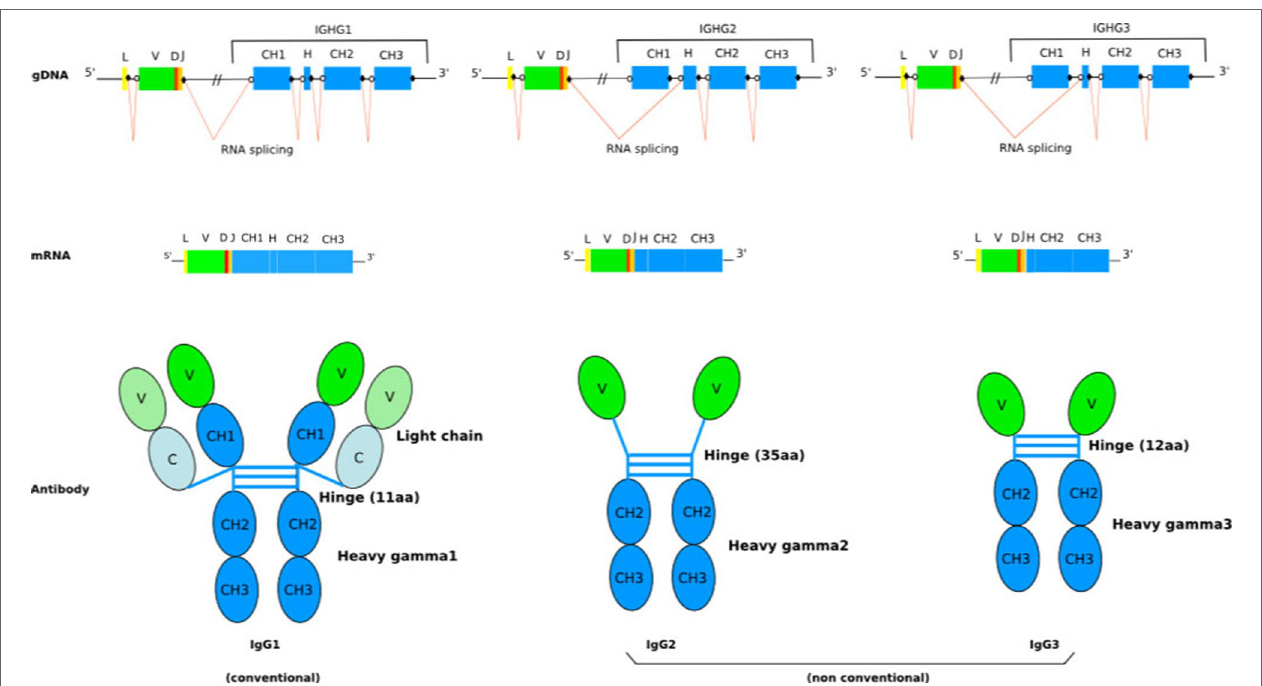
FIGURE 1 | Schematic representation of the general structure of camel conventional IgG1 and the nonconventional IgG2 and IgG3. The lack of light chain is itself a consequence of the absence of the CH1 domain in the gamma 2 and gamma 3 chains, due to a splicing defect of the CH1 exon. The figure is from IMGT: Camelidae IgG antibodies (http://www.imgt.org/IMGTbiotechnology/Camel_IgG.html#characteristics) with permission of IMGT ® , the international ImMunoGeneTics information system ® (http://www.imgt.org).